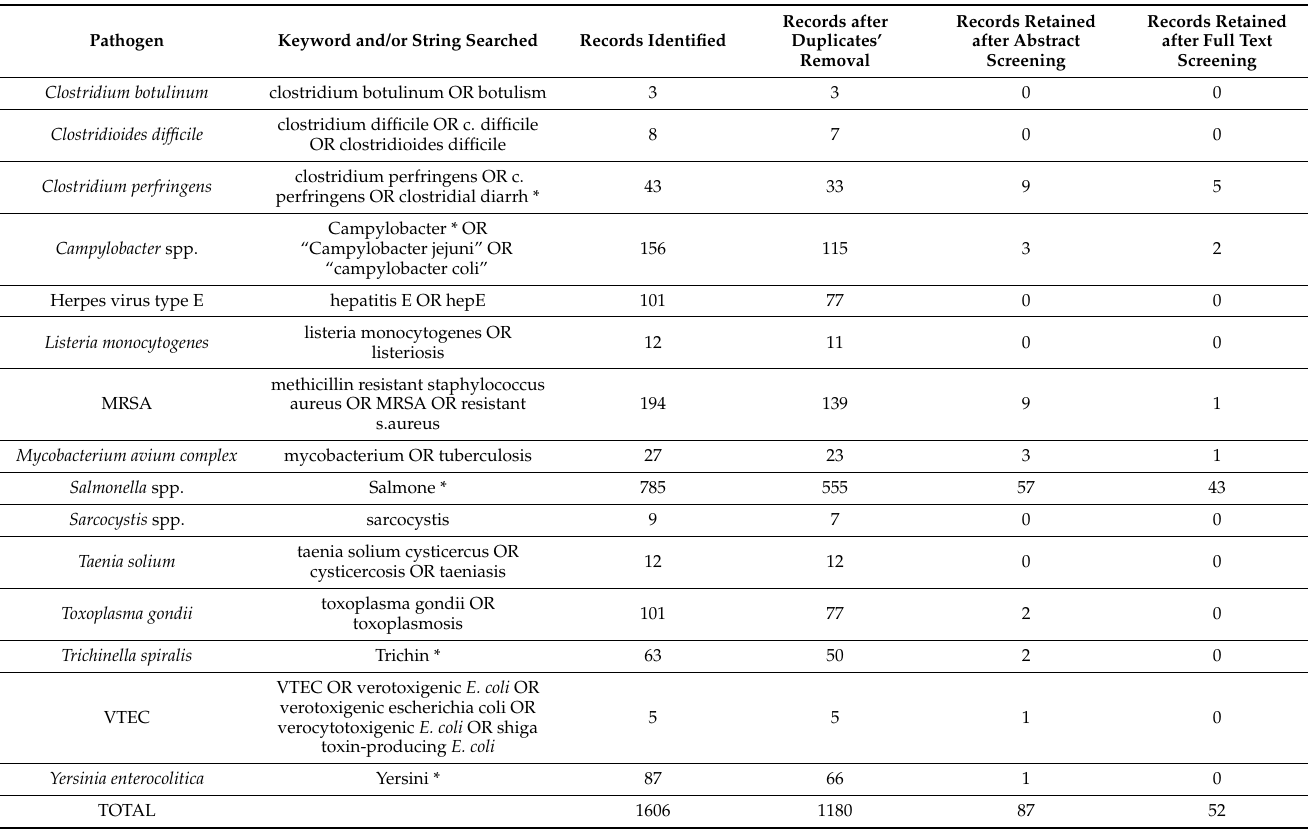
Figure 1. Structure outline of text strings used for the searches conducted in PubMed ® and the Web of Science databases on 8 February 2021 (reproduced from Pessoa et al. [4], which employed the same methods). The search strings used are available as Supplementary Material. Table 1. Flow of information through the systematic review for 15 foodborne pathogens, including keyword and/or string searched for each pathogen.